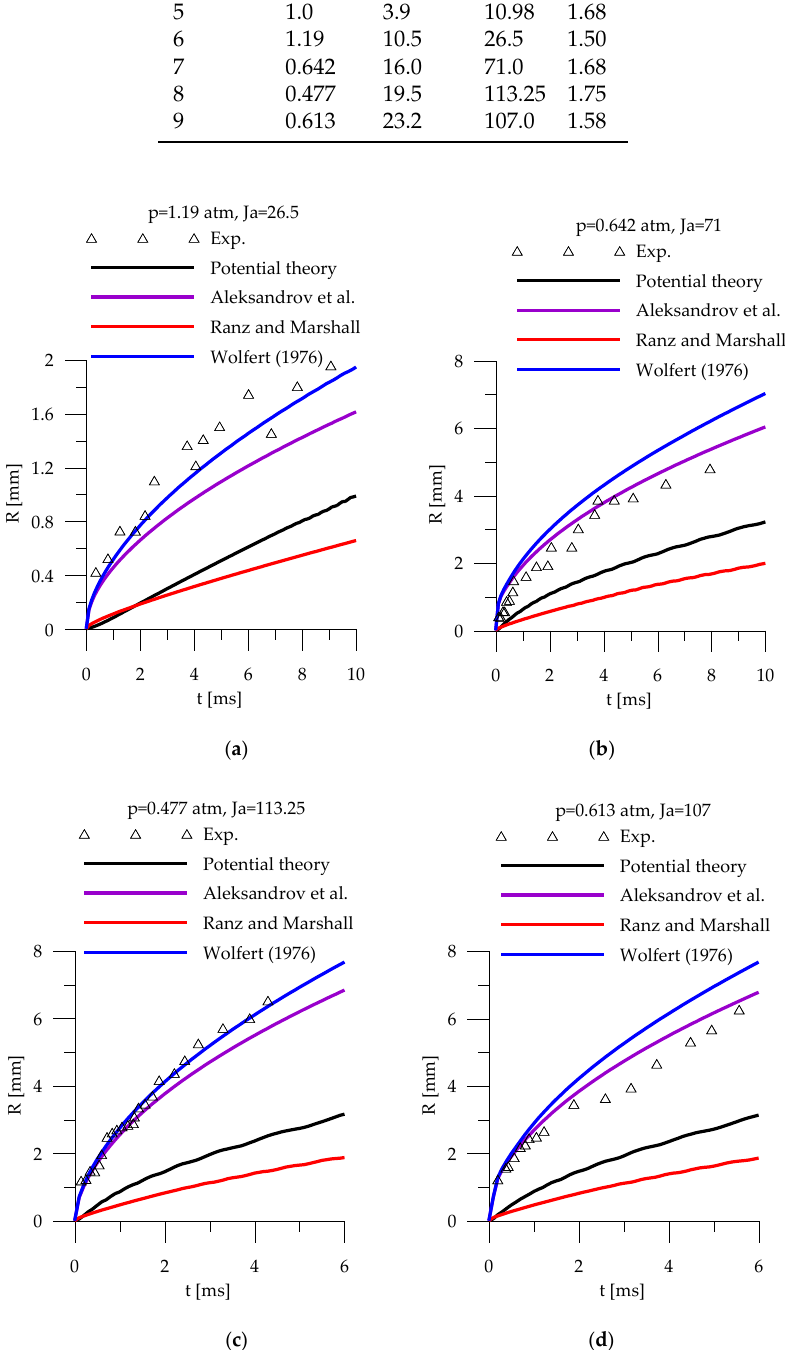
Figure 12. Simulated and measured bubble radius at normal gravity (experimental data from [67]): ( a ) T sup = 10.5 K. ( b ) T sup = 16.0 K. ( c ) T sup = 19.5 K. ( d ) T sup = 23.2